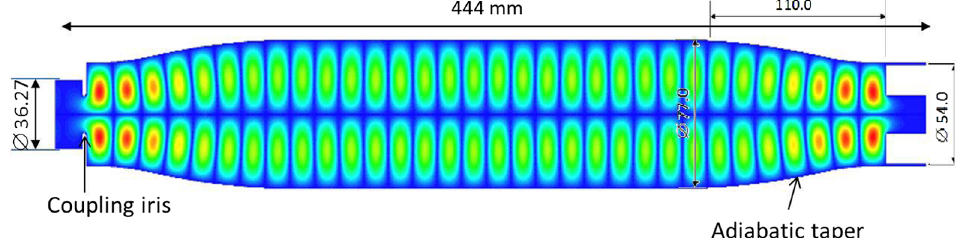
FIG. 3. Electric field pattern inside of the storage cavity of the new SLED-I [20].